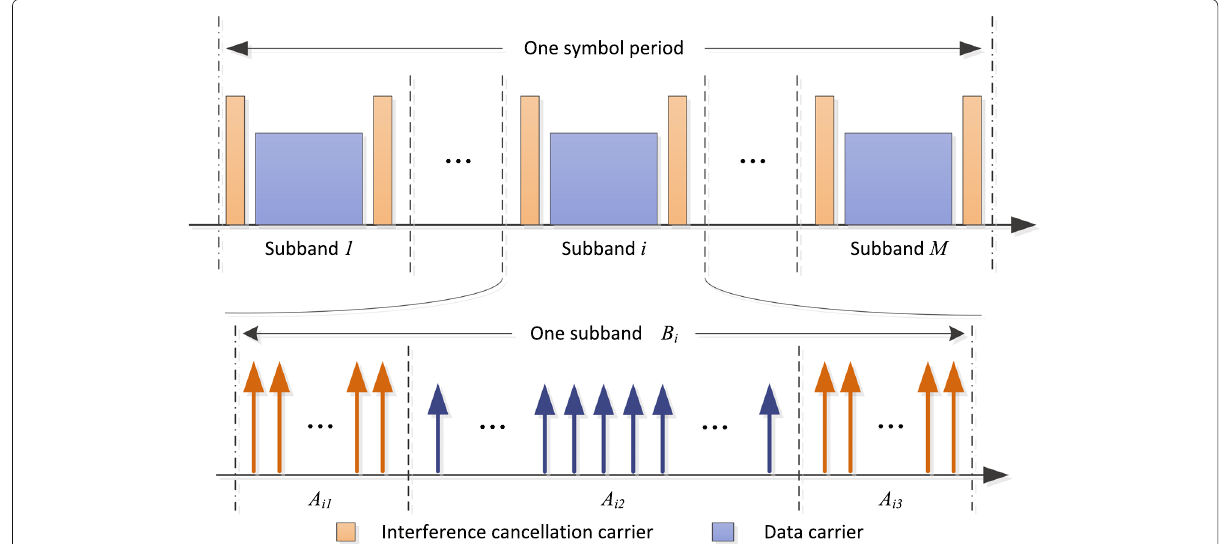
Fig. 2 Bandwidth allocation of the proposed scheme for UFMC. This figure illustrates the bandwidth allocation of the three parts in one subband for the proposed